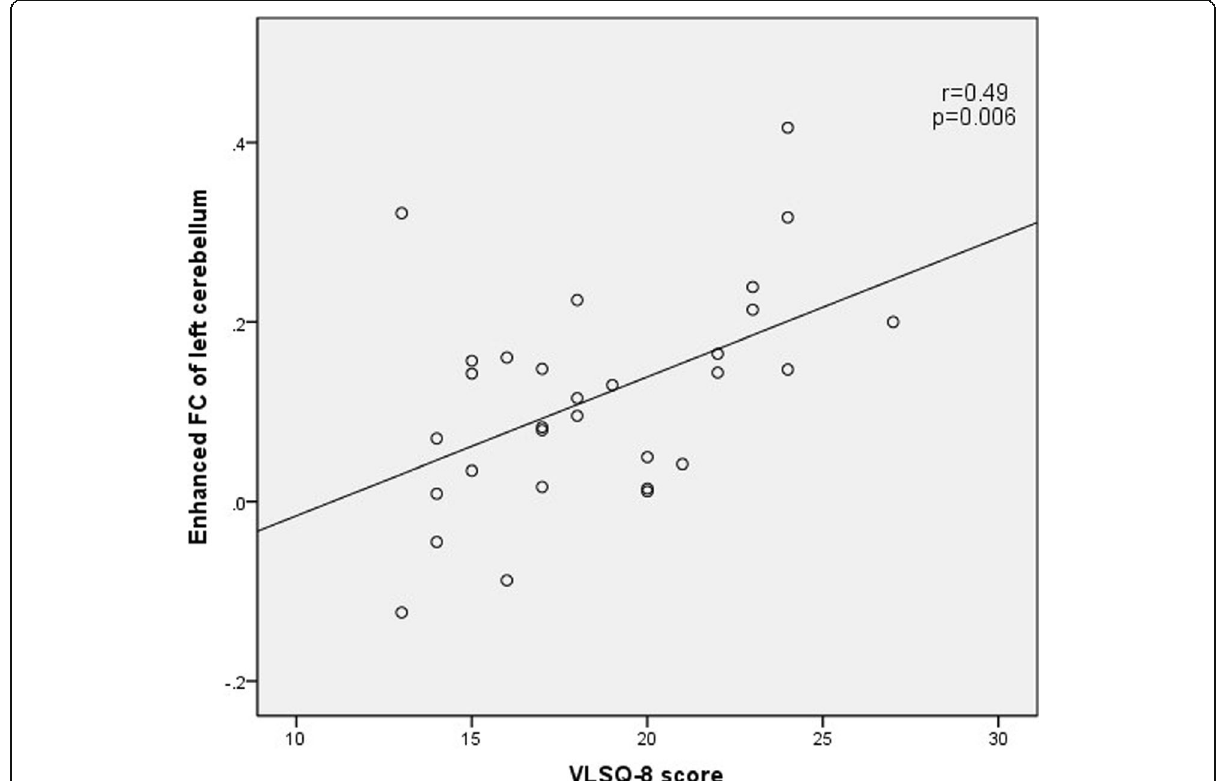
Fig. 3 The correlation of the VLS score with the enhanced FC of left cerebellum in MwoA compared with